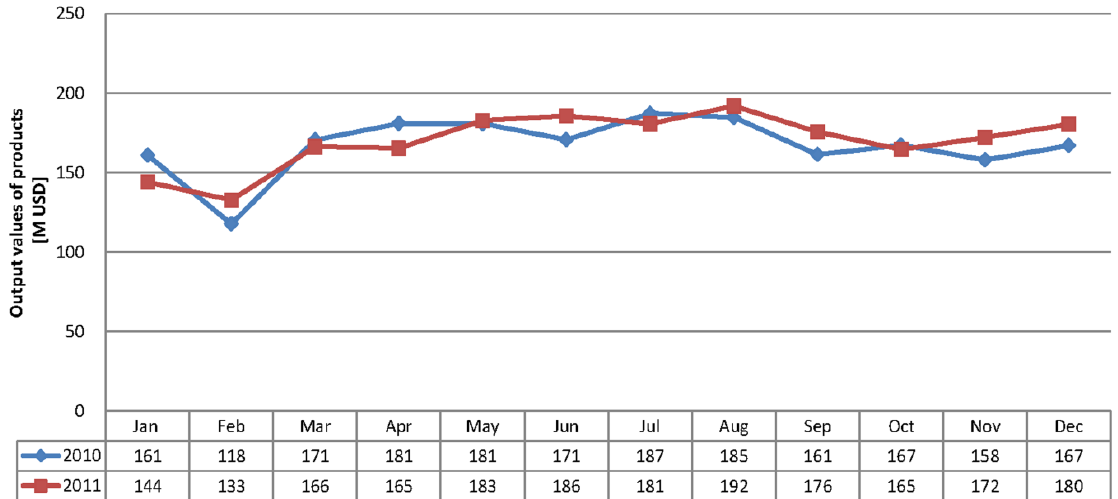
Figure 5. Comparison of output values before and after implementing the ISO 50001 standard in